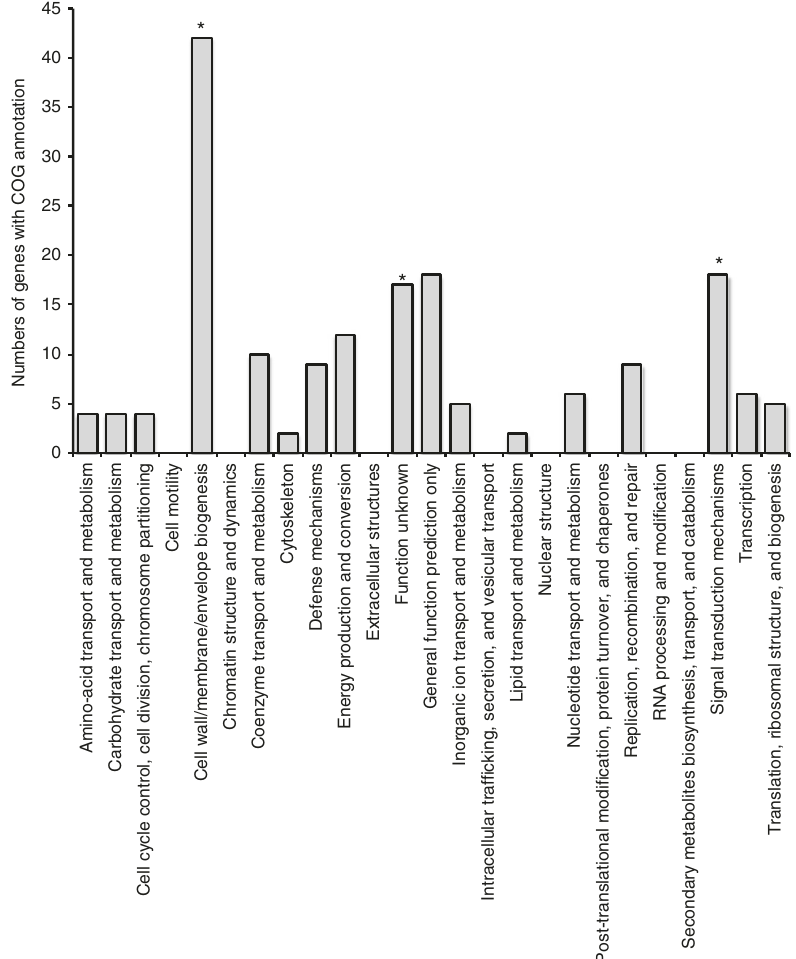
Fig. 4 COG categories for all gene clusters that were unique to Sulfurovum MAGs. FS854_Bin37 and FS856_Bin99. COG categories that were signi fi cantly enriched relative to all genes in all Sulfurovum MAGs are indicated with